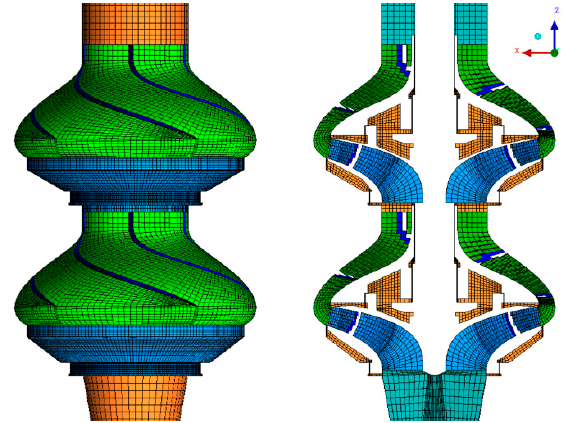
Table 4. Results from the mesh independence analysis. Grid Number